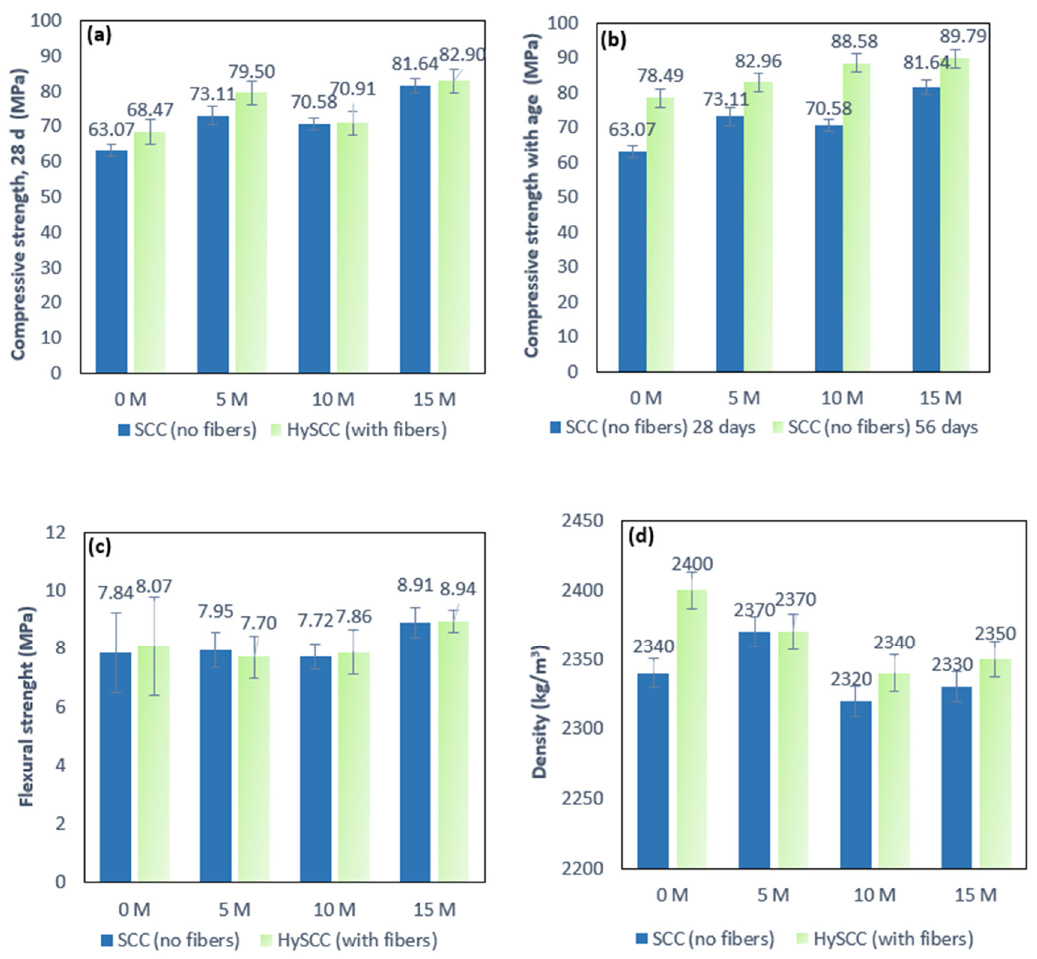
Figure 2. Effects of metakaolin and hybrid fibers on ( a , b ) the compressive strength of SCC at 28 days and 56 days, ( c ) flexural strength at 28 days, and ( d ) density in a hardened state.